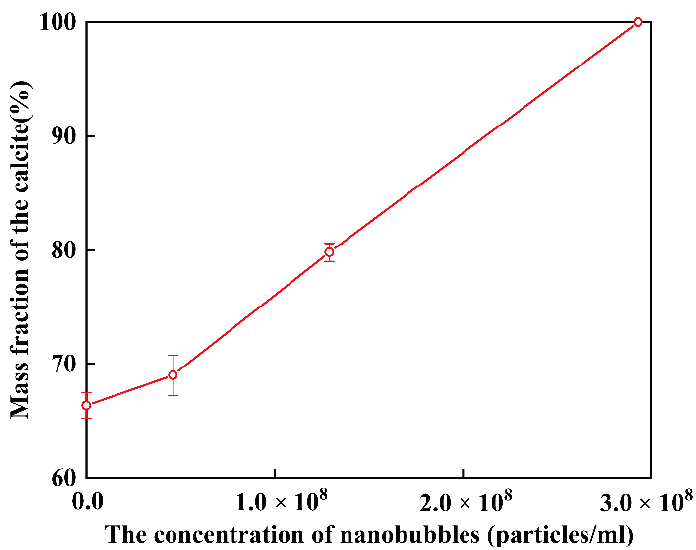
Figure 8. Mass fraction of the calcite (W calcite /W calcite+vaterite ) as a function of the concentration of nanobubbles in deionized water after 4 h.